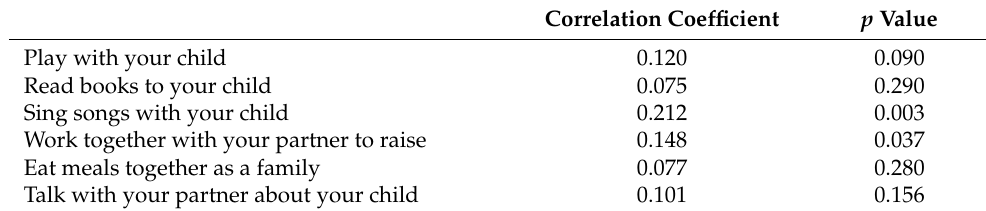
Table 2. The relationship between social development and childrearing environment.